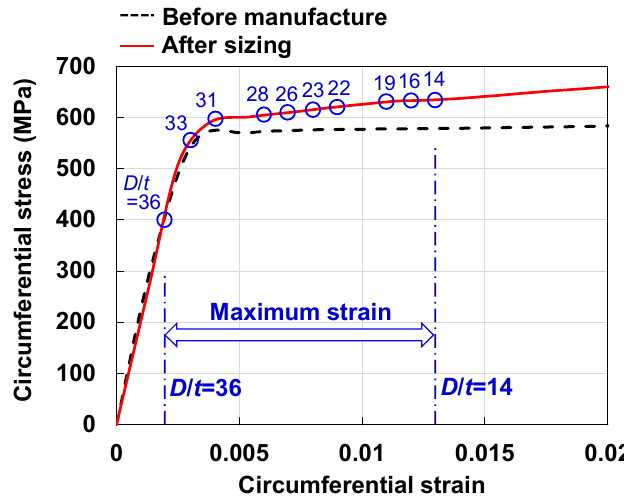
Figure 11. Range of maximum compressive strain when collapse occurs.